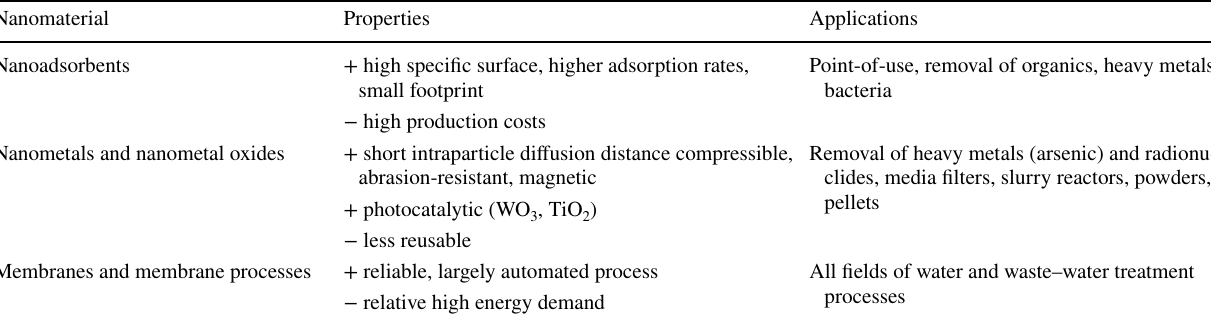
Table 6 Overview of the types of nanomaterials applied for water and wastewater technologies (Gehrke et al. 2015)